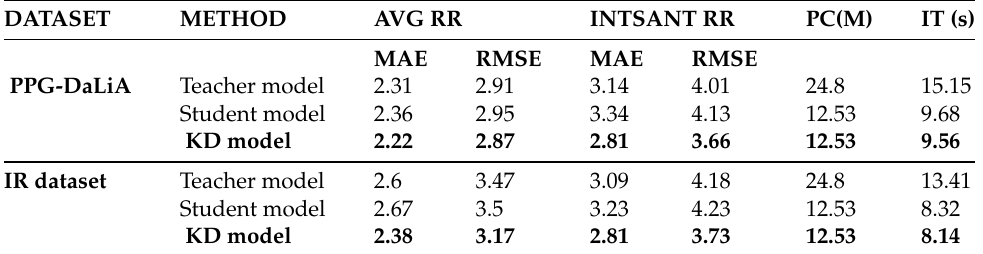
Table 6. Comparison between teacher model, student model, and proposed model with KD.